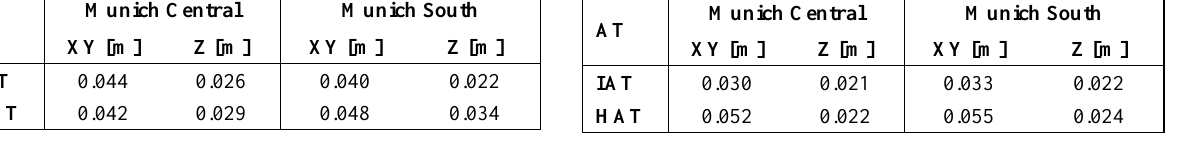
Table 11. Control point residuals (RMS).